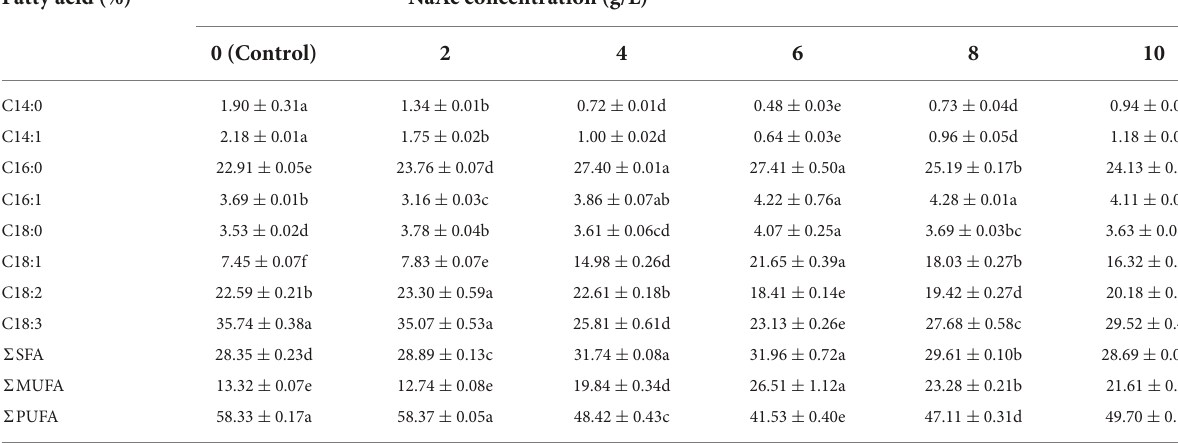
TABLE 2 The fatty acid compositions of C. reinhardtii under different NaAc concentrations.